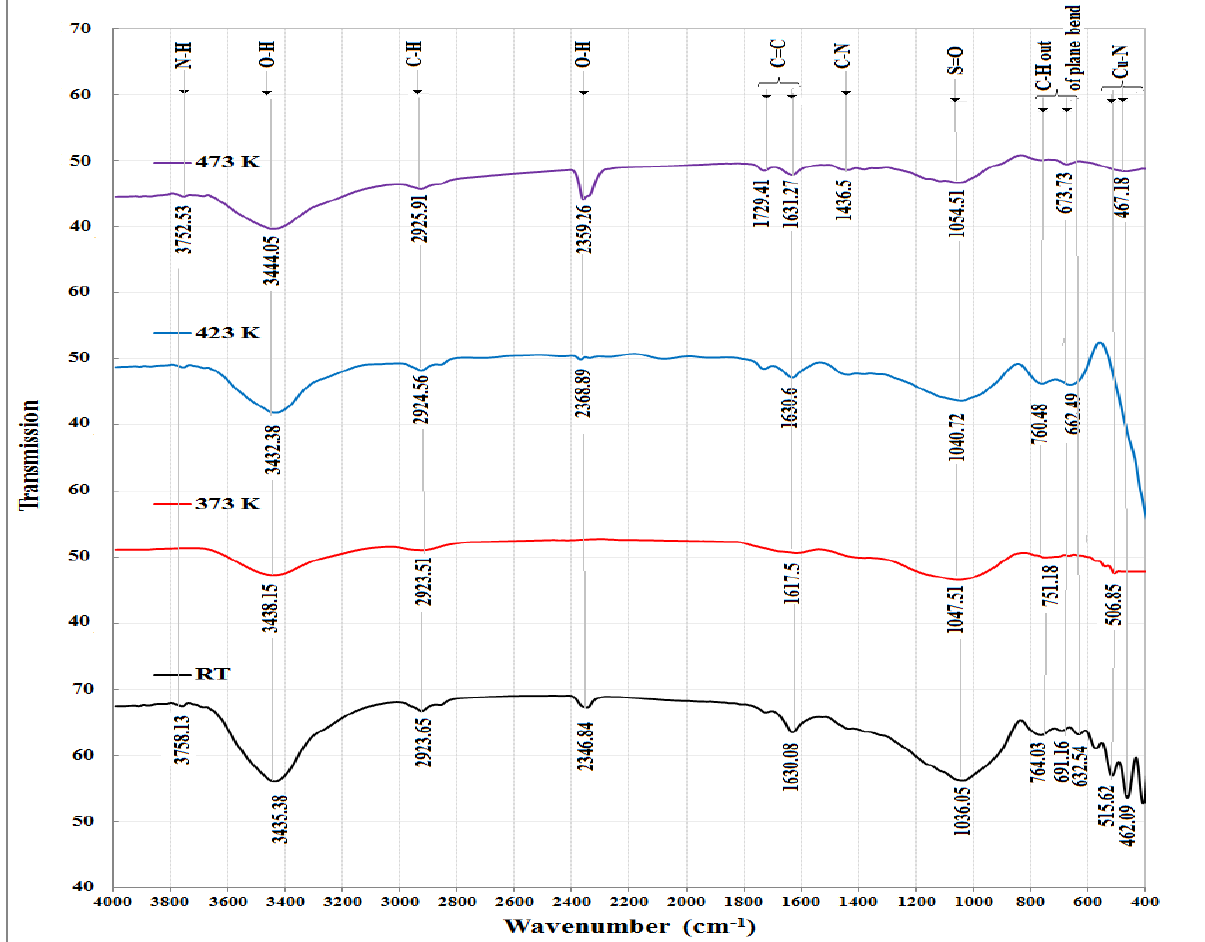
Fig. 3: FTIR patterns for CuPcTs/BEDOT:PSS thin films at different annealing